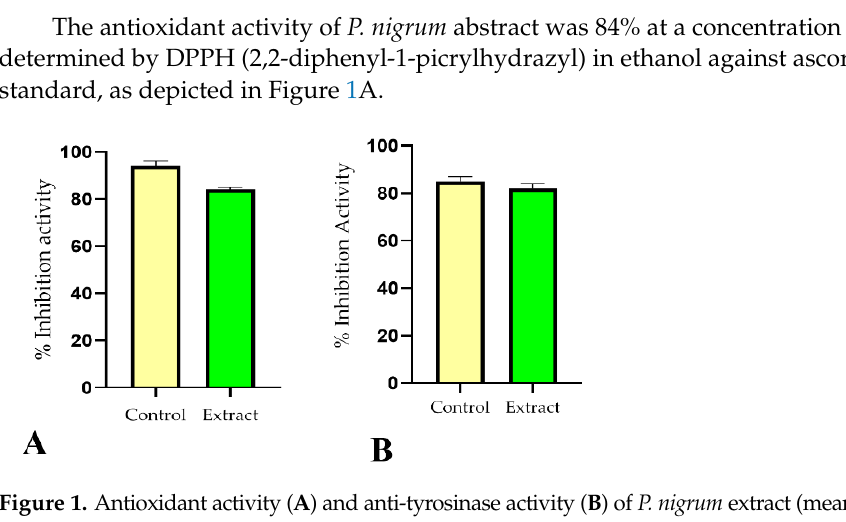
Figure 1. Antioxidant activity ( A ) and anti-tyrosinase activity ( B ) of P. nigrum extract (mean ± SD, n = 3).